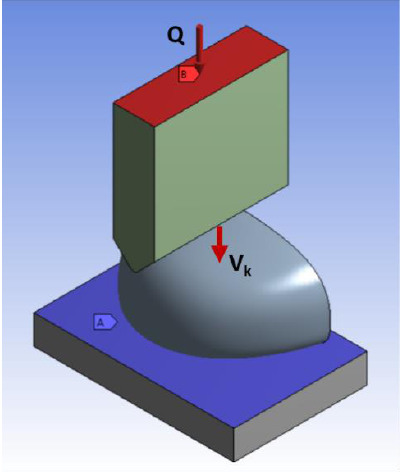
Figure 3. Boundary conditions for toecap FEM.